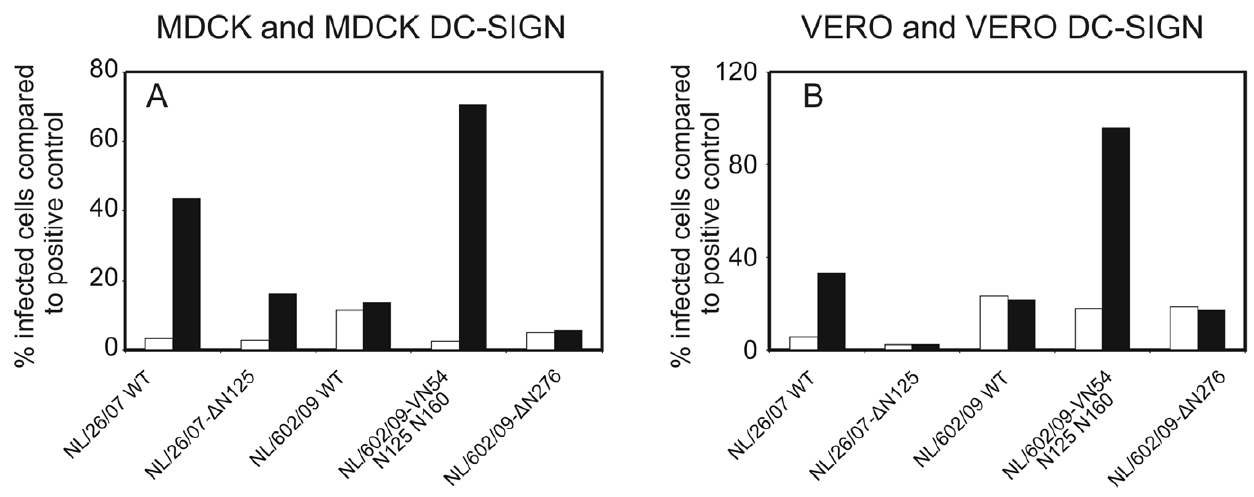
Figure 7. The number of glycosylation sites present on HA determines the virus infection rates in DC-SIGN expressing cells. MDCK (A) and Vero (B) cells, transfected with the DC-SIGN gene (black bars) or not (white bars) were treated with neuraminidase from vibrio cholerae and GolgiStop for 30 minutes to remove sialic acids from the cell surface. These cells were subsequently inoculated with A/Netherlands/26/07, A/ Netherlands/26/07- D 125, A/Netherlands/602/09, A/Netherlands/602/09- D 276 or A/Netherlands/602/09-VN54 N125 N160. The percentage of infected cells relative to the positive control (untreated cells still possessing sialic acid) was assessed after detecting infected cells using a FITC-labeled antibody to the viral nucleoprotein and